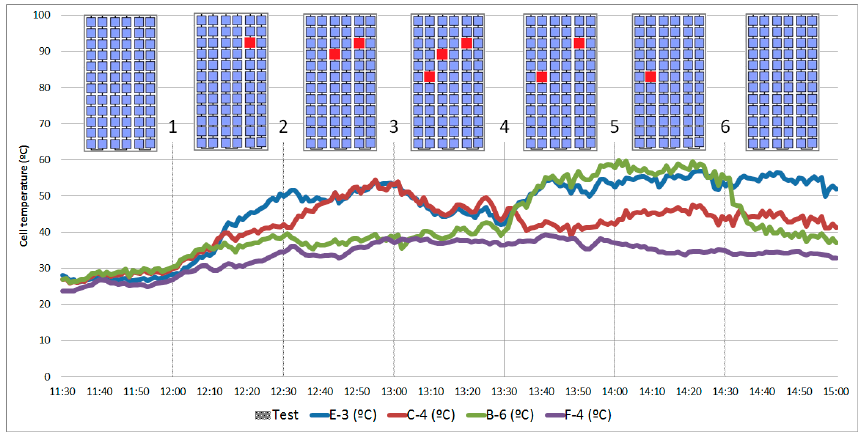
Figure 13. Thermocouple temperatures on the backside of the PV module in test 2.